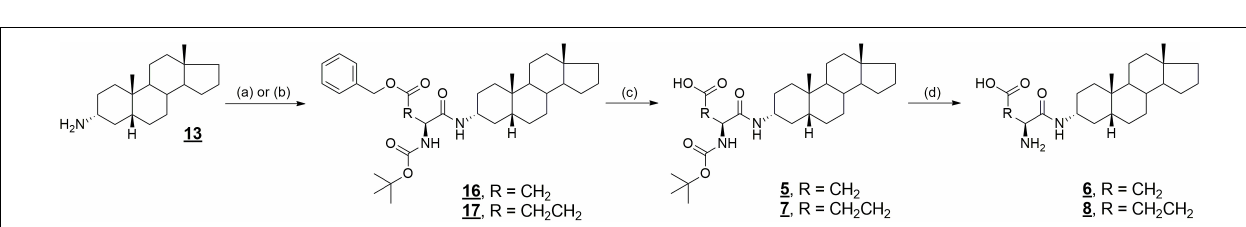
Frontiers in Pharmacology |